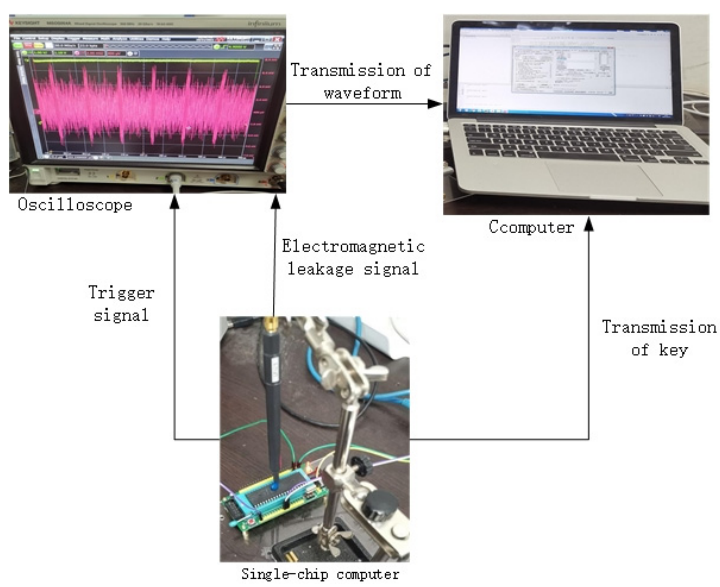
Figure 2. Experimental acquisition platform.